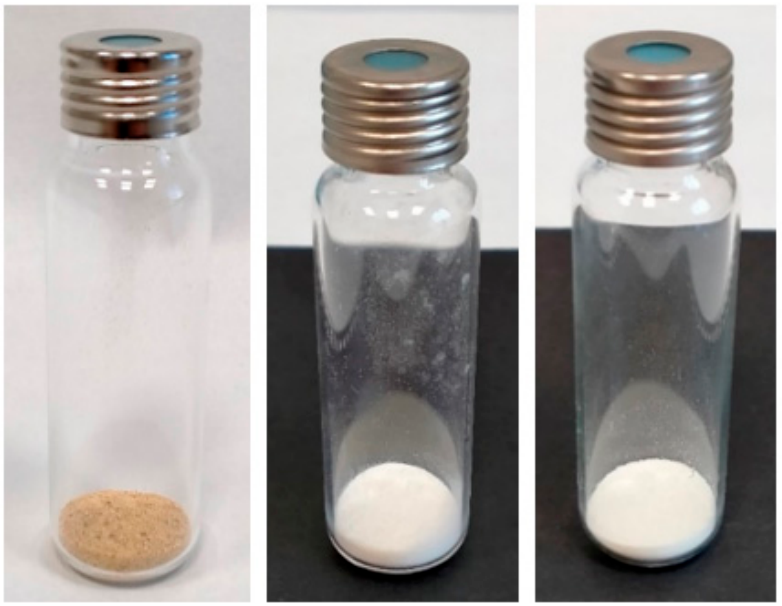
Figure 1. Images of the M_AI_V_t 0 ( left ), M_B_O_t 0 ( middle ) and M_B_O_t 24 ( right ) samples from winter melon pomace fiber.